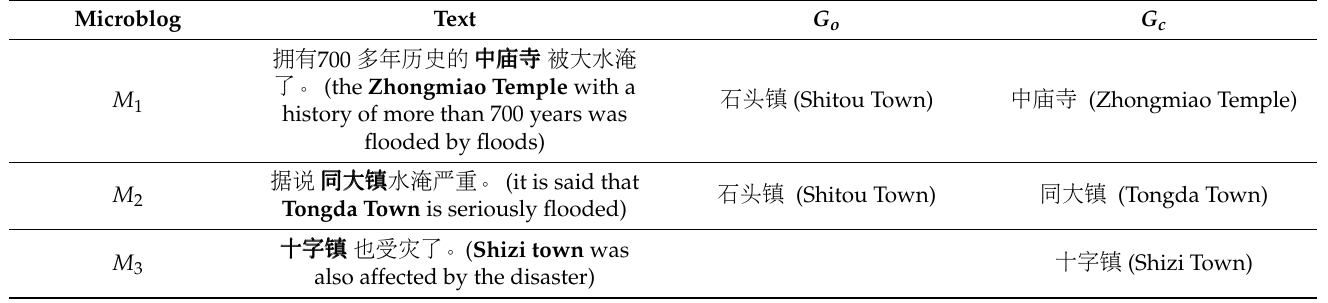
Table 1. Relationship between location information related to social media.